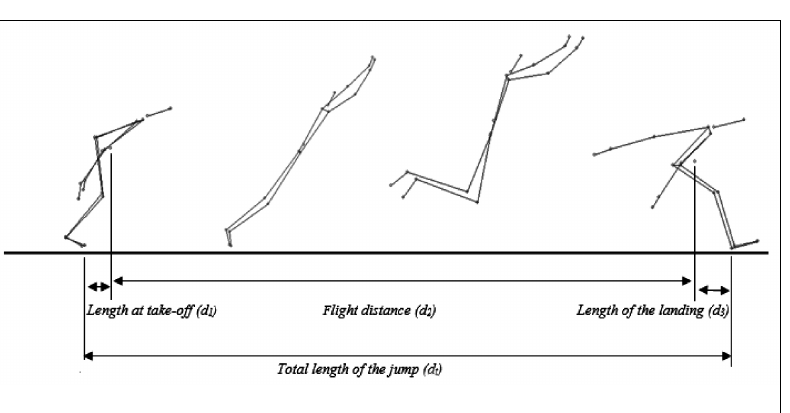
Figure. Standing long jump performed by students from the Faculty of